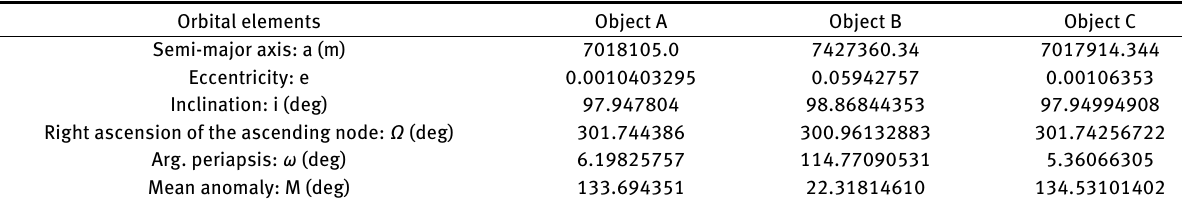
Table 1. The initial orbital elements of debris objects